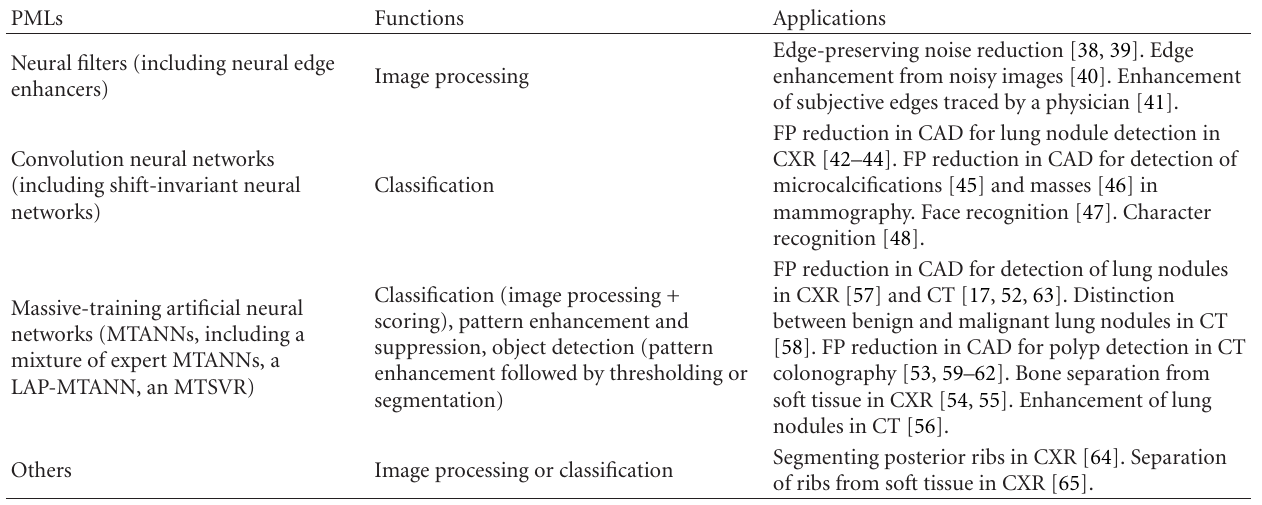
Table 1: Classes of PMLs, their functions, and their